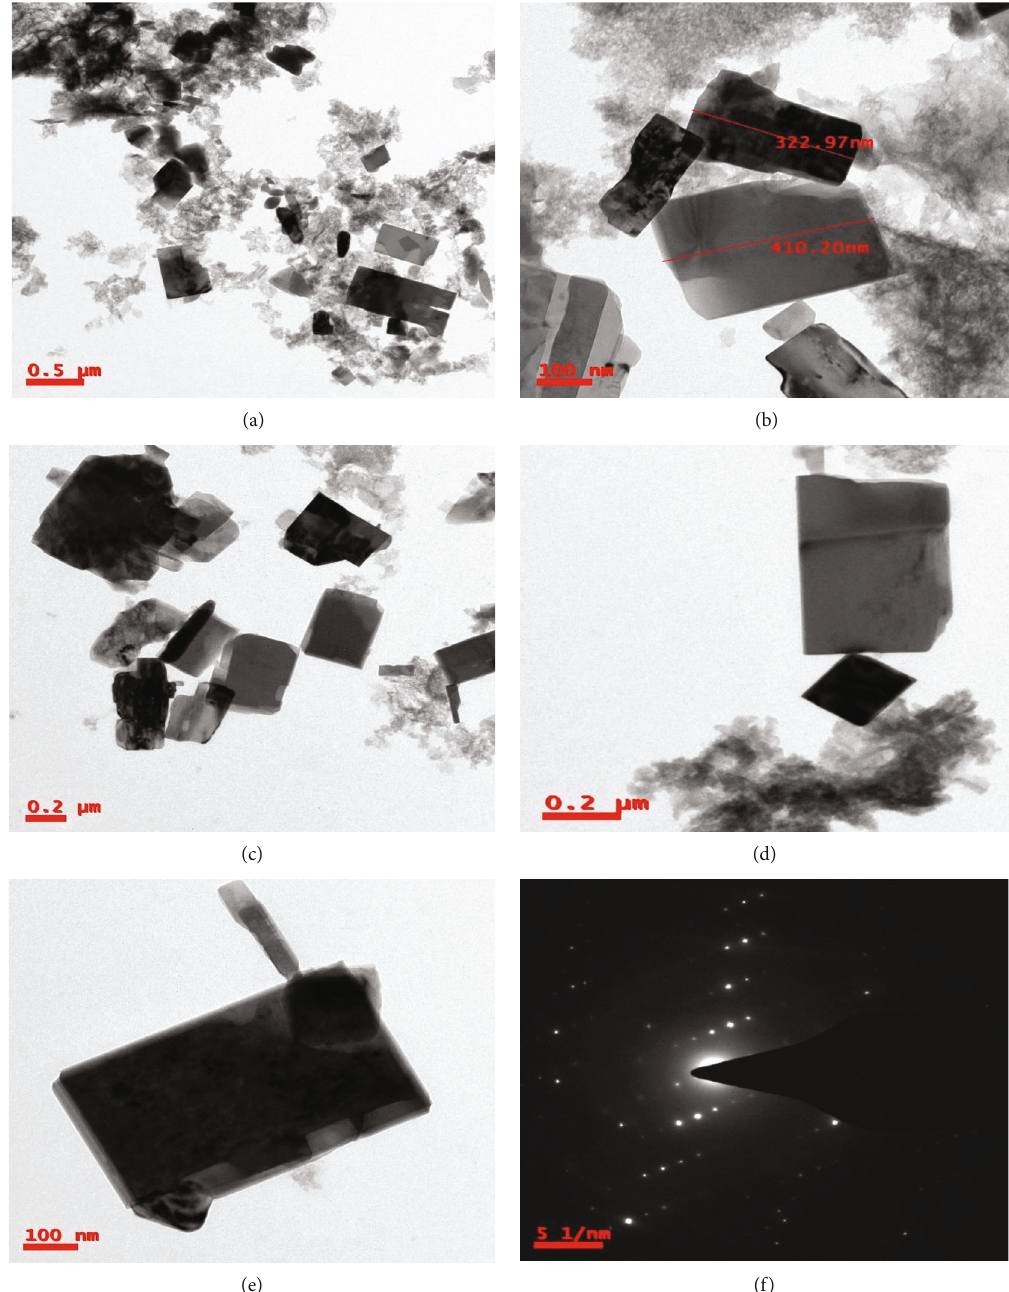
Figure 7: TEM micrographs of (a – e) calcium-rich zeolites and (f) SAED pattern.